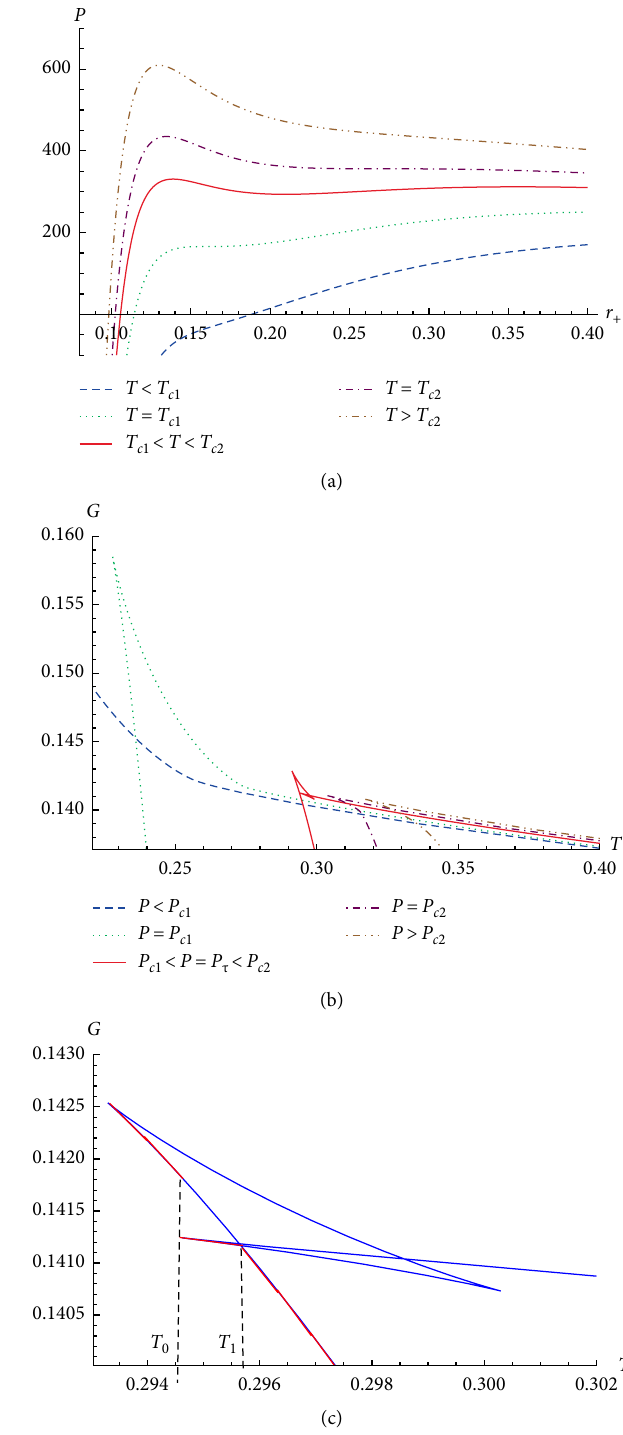
Figure 3: The 𝑃 − 𝑟 and 𝐺 − 𝑇 diagrams of four-dimensional + charged AdS black holes with 휔 = − 1.03 , 휉 = 2.1 , 푄 = 0.4 , 𝑝 and 푁 = 0.1113 . It shows the existence of two critical points 𝑝 = 356.10, 푇 = 0.3153) . (푃 = 165.8340, 푇 = 0.2743) and (푃 푐2 푐2 푐1 푐1 For 푃 ∈ (푃 , 푃 ) , we observe a “zeroth-order phase transition” at 𝑇 0 𝜏 𝑧 signifying the onset of an RPT in ( c )